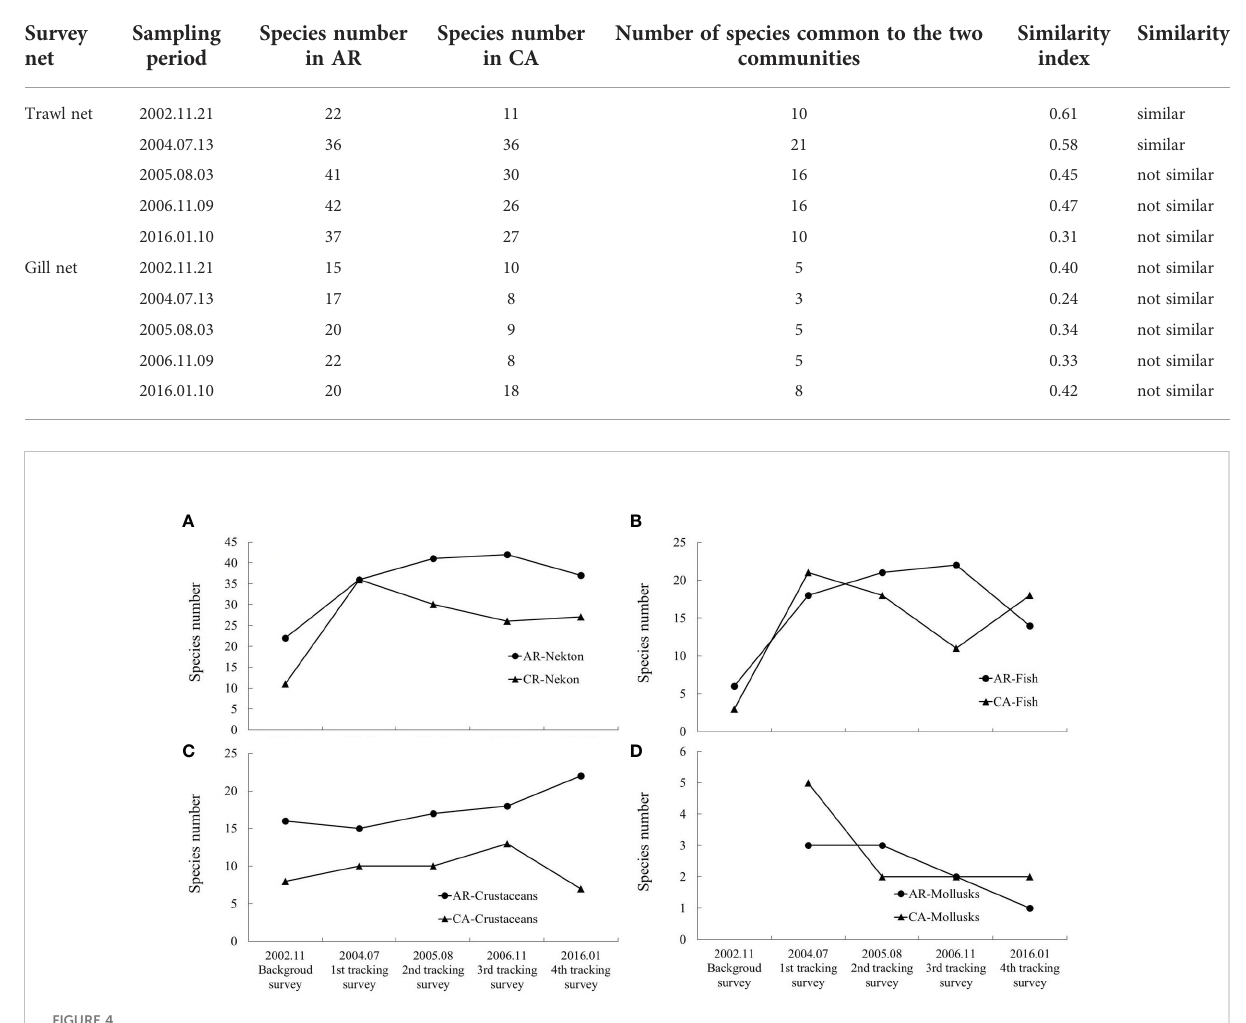
FIGURE 4 Species composition of nekton (A) , fi sh (B) , crustaceans (C) and mollusks (D) collected during each trawl net sampling periods in AR and CA habitats.